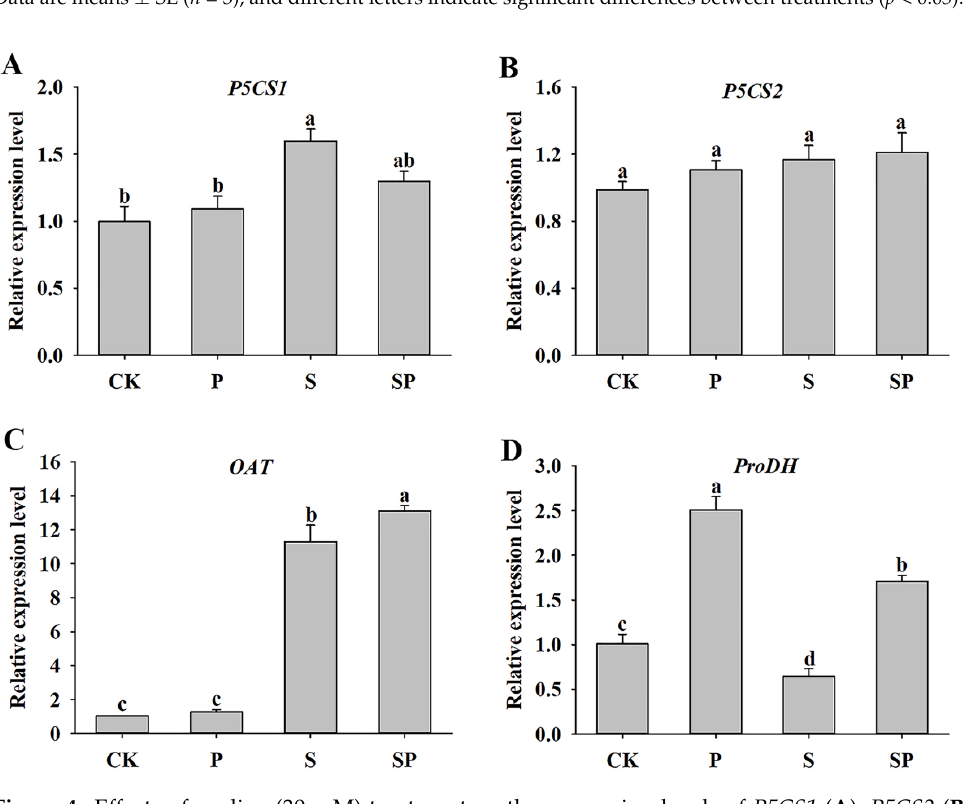
Table 3. Effects of proline (30 mM) treatment on proline content, P5CS activity, OAT activity, and ProDH activity of alfalfa under salt stress.